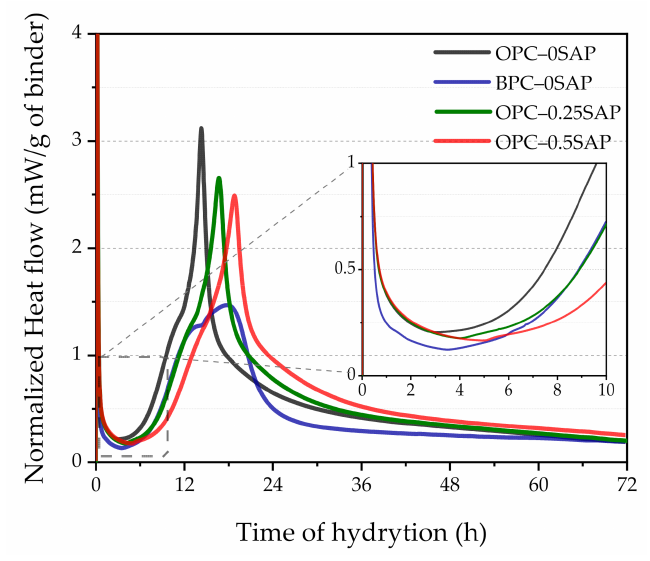
Figure 9. Exothermic rate of hydration of the mixed paste at 20 ◦